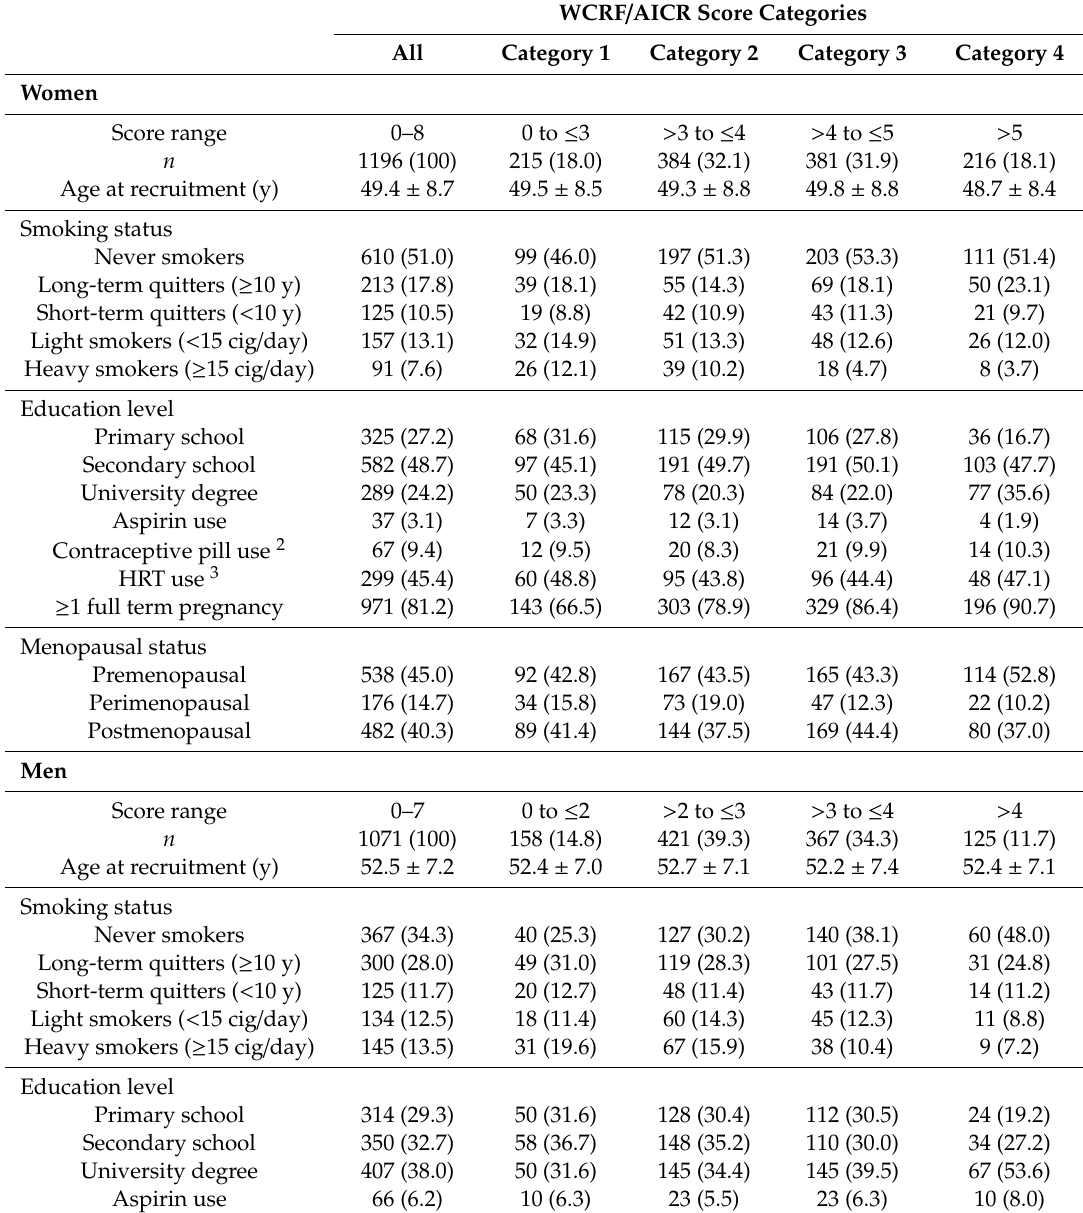
Table 2. Baseline characteristics of 2267 individuals of the EPIC Heidelberg subcohort according to categories of the WCRF / AICR score 1 by